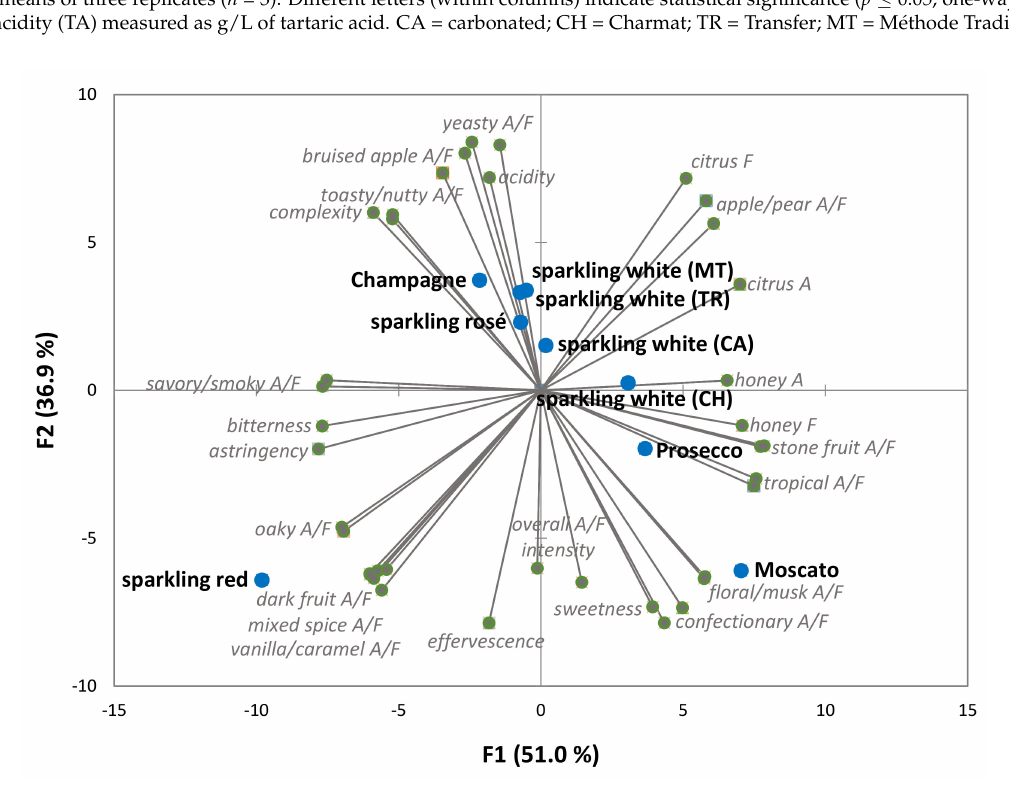
Figure 1. Principal component analysis biplot of sensory attribute ratings of the French Champagne and Australian sparkling wines studied. CA = carbonated; CH = Charmat; TR = Transfer; MT = M é thode Traditionelle; A = aroma; F =